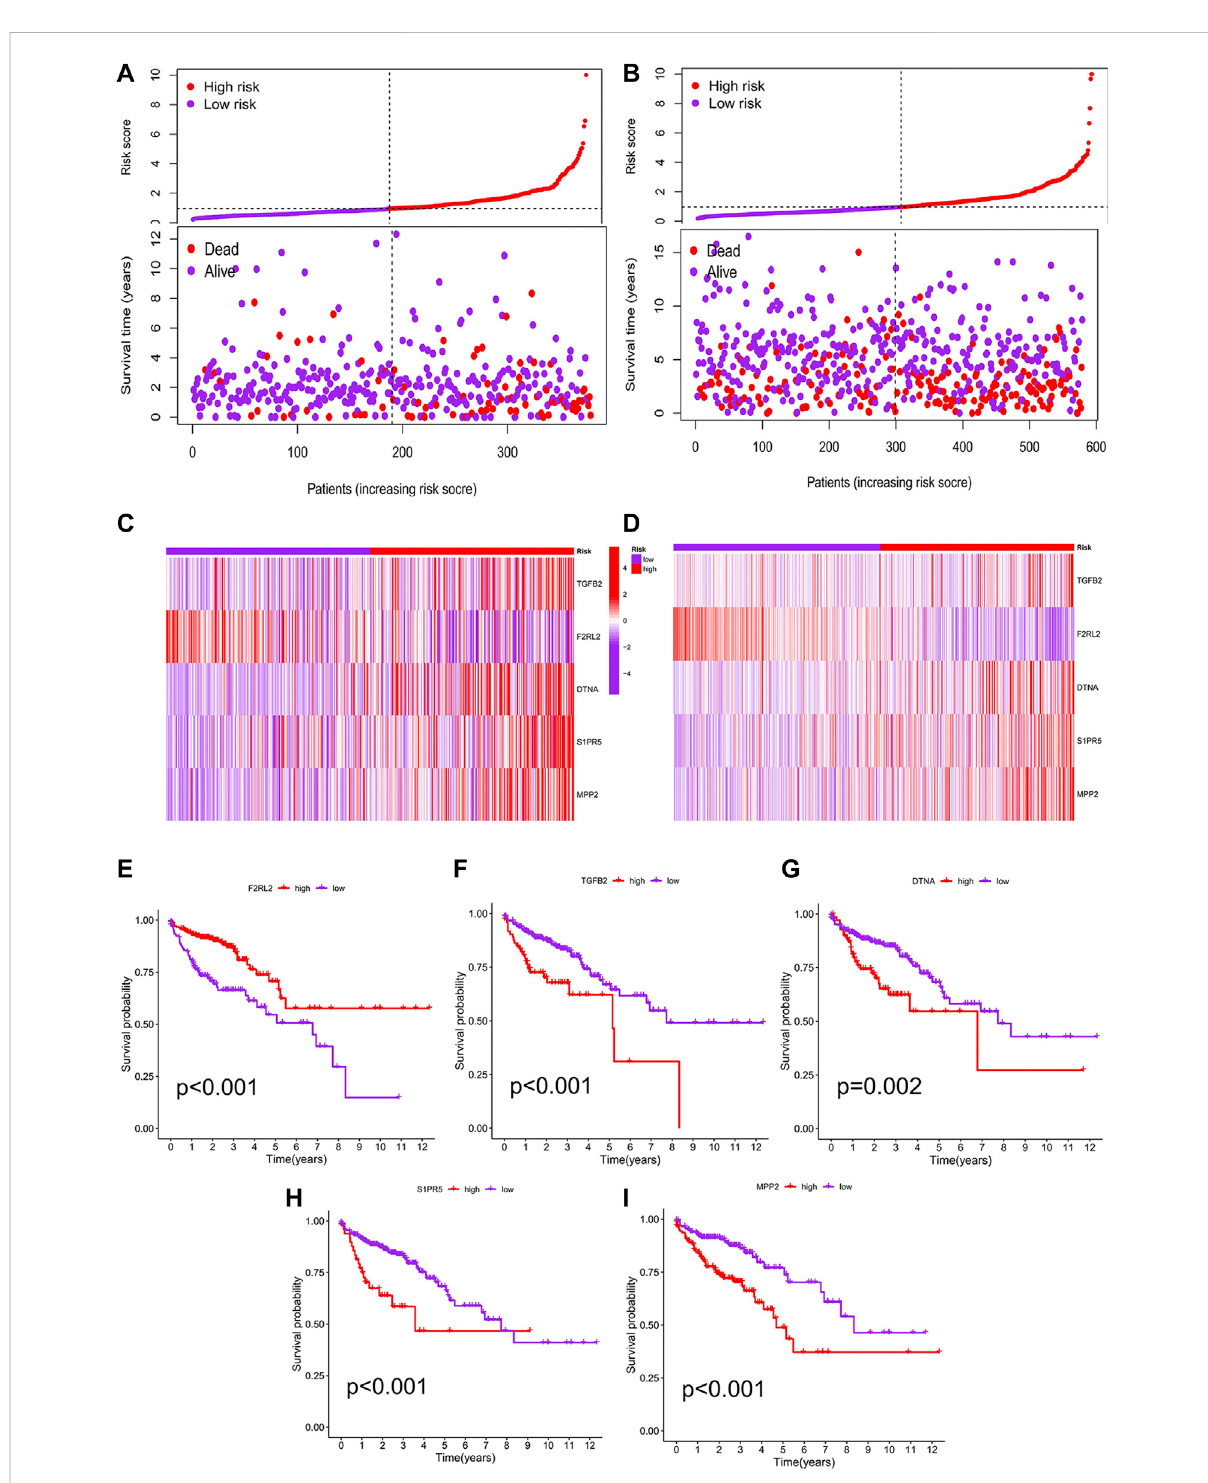
FIGURE 5 Correlation analysis between risk score and prognosis. (A) Patients in the prognostic model were divided into high- and low-risk groups according to the median value of risk score. With the increase in risk score, the number of deaths increased correspondingly, and the survival prognosis of patients with low risk was better. (B) Conclusions of the prognostic model were validated by the GEO testing set. (C) F2RL2 was con fi rmed to be a low-risk gene, while TGFB2, DTNA, S1PR5, and MPP2 were high-risk genes. (D) Conclusions of hub genes were validated by the GEO testing set. (E – I) K-M analysis results of fi ve hub genes: F2RL2, TGFB2, DTNA, S1PR5, and